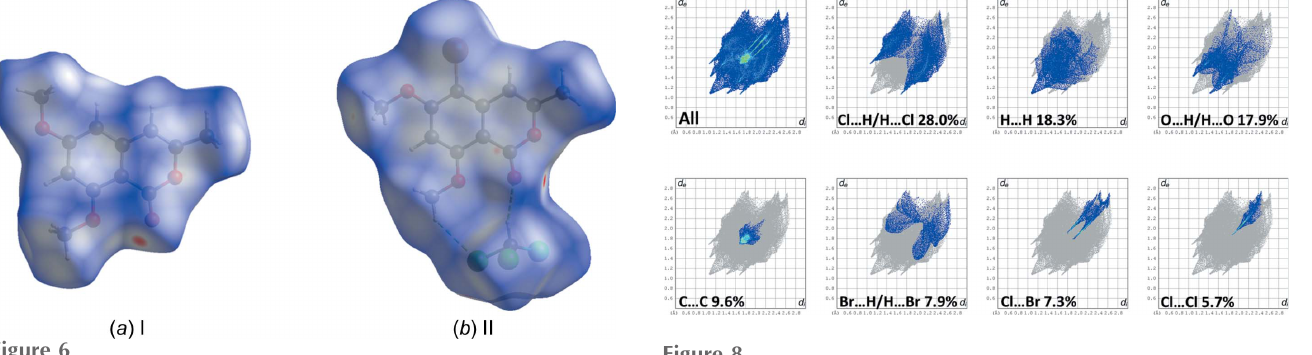
Figure 8 The full two-dimensional fingerprint plot for compound II (cid:2) CHCl 3 , and fingerprint plots delineated into Cl (cid:2)(cid:2)(cid:2) H/H (cid:2)(cid:2)(cid:2) Cl (28.0%), H (cid:2)(cid:2)(cid:2) H (18.3%), O (cid:2)(cid:2)(cid:2) H/H (cid:2)(cid:2)(cid:2) O (17.9%), C (cid:2)(cid:2)(cid:2) C (9.6%), Br (cid:2)(cid:2)(cid:2) H/H (cid:2)(cid:2)(cid:2) Br (7.9%), Cl (cid:2)(cid:2)(cid:2) Br